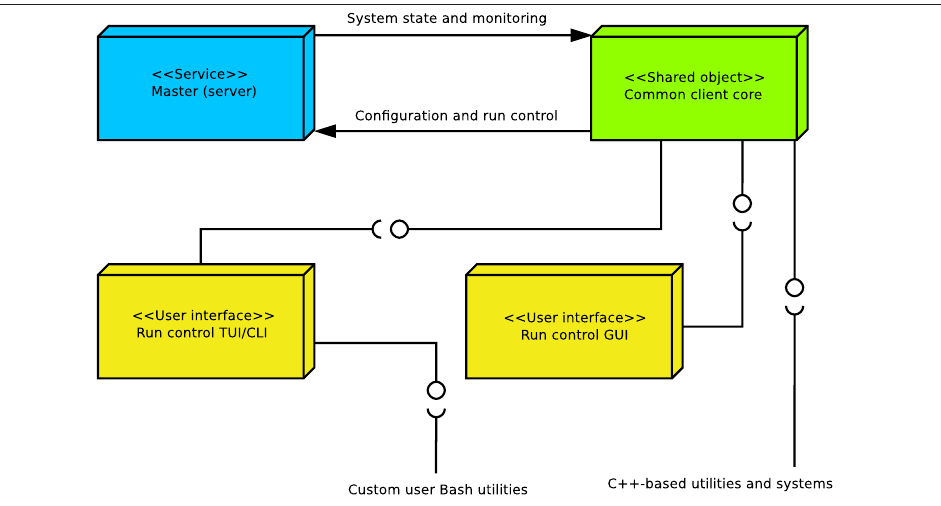
Figure 2. New iFDAQ interface architecture